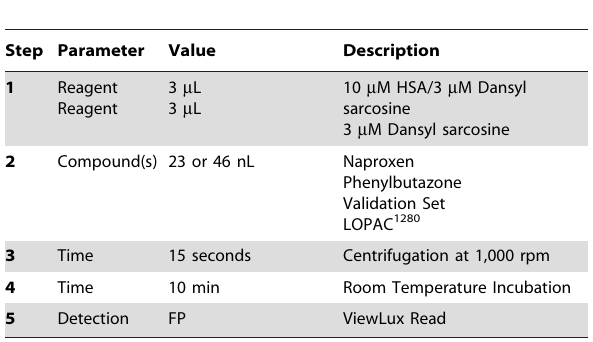
Table 2. HSA Assay Protocol for 1,536-well Format.